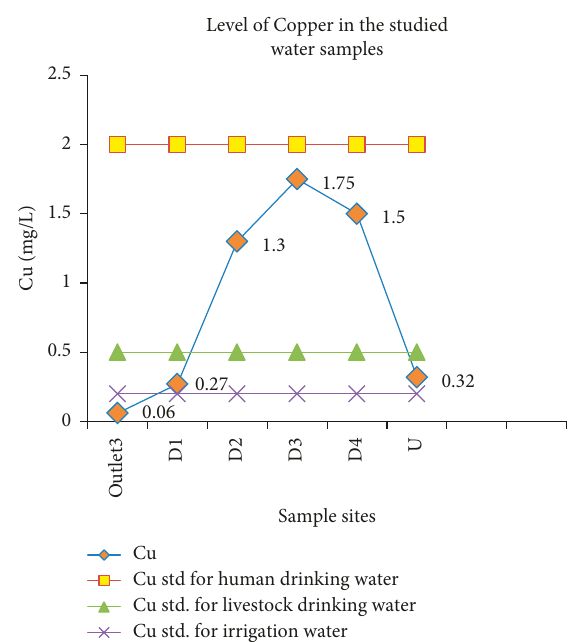
Figure 11: Comparison of the copper concentration in wastewater discharged from the Zenzelma campus and the recommended limits of